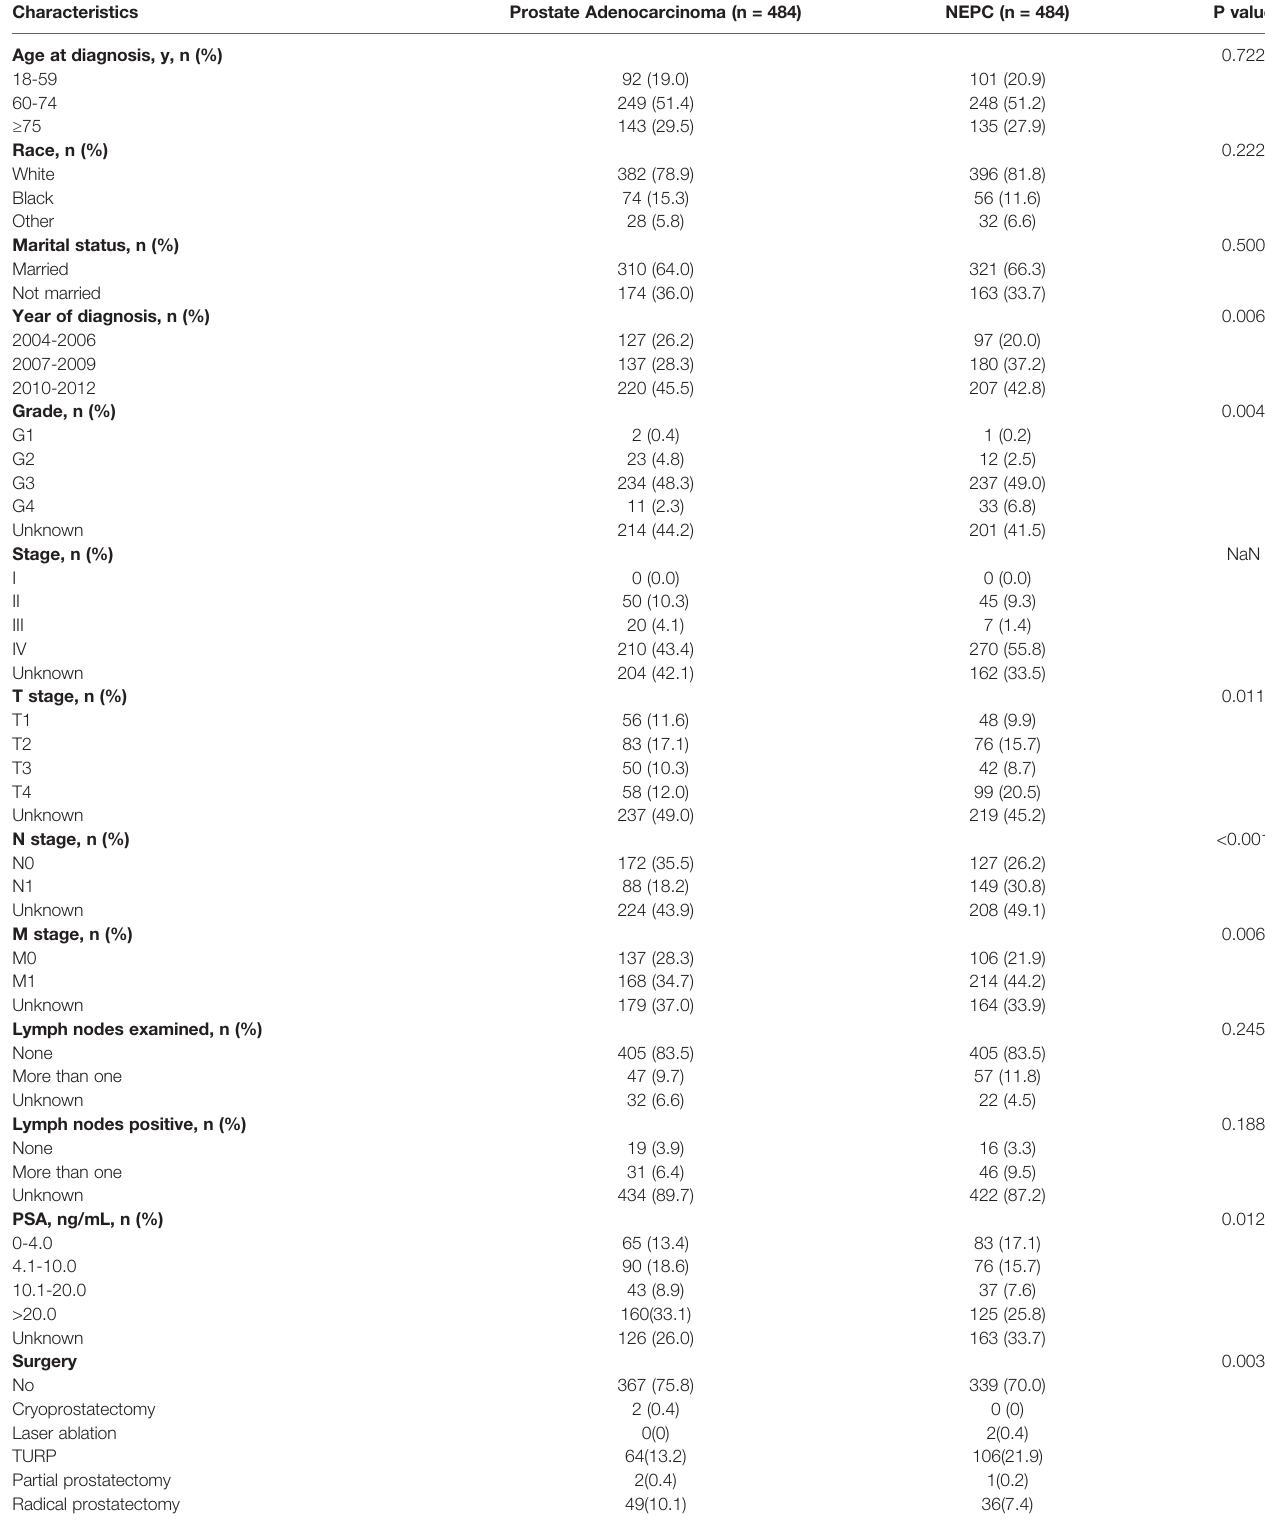
TABLE 4 | Propensity score matching for baseline factors.